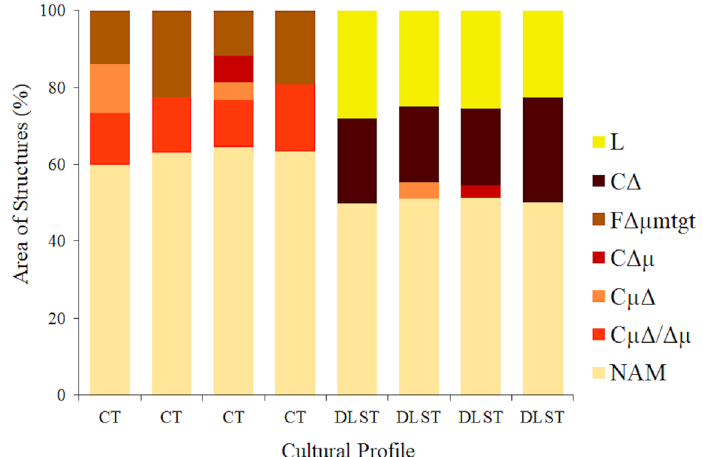
Figure 3. Percentage areas of structures in a dystrophic Red-Yellow Latosol under conventional tillage (CT) and deep localized soil tillage (DLST).Field replication. Organization of clods: L = free soil volume, C = continuous soil volume, F = cracked soil volume, NAM = unaltered soil volume by use and management, mt = medium clods (7 cm Ø), gt = large clods (10 cm Ø). Internal states of clods: μΔ = porous with indications of compression, μΔ/Δμ = medium porosity, Δμ = compact with some porosity, Δ = compact with no visible porosity to the naked